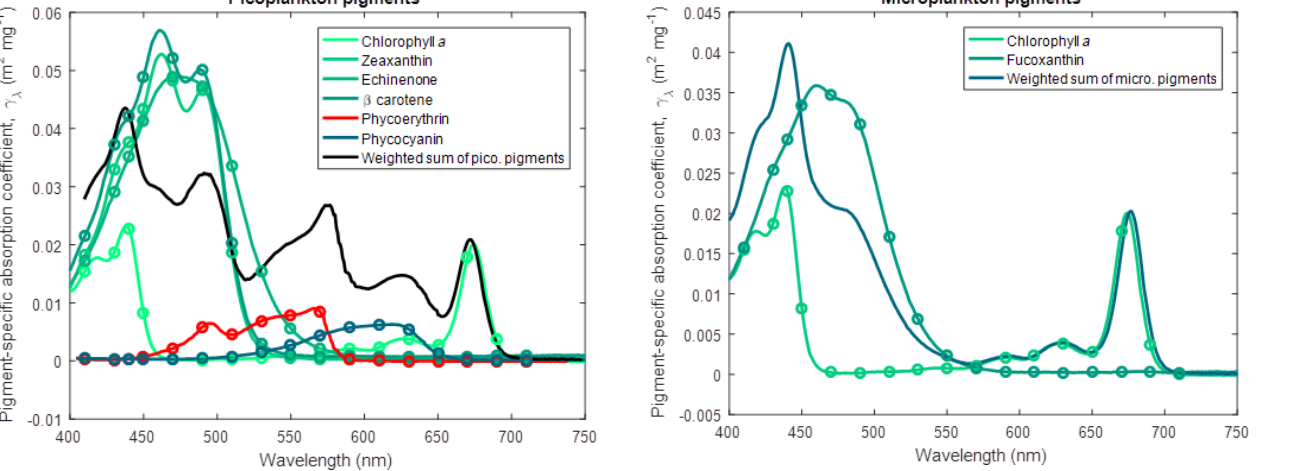
Figure 5. Pigment-specific absorption coefficients for the dominant pigments found in small phytoplankton determined using labora- tory standards in solvent in a 1cm vial. Green and red lines are pho- tosynthetic pigments constructed from 563 measured wavelengths. Circles represent the wavelengths at which the optical properties are calculated in the simulations. The black line represents the weighted sum of the photosynthetic pigments (Eq. 3), with the weighting calculated from the ratio of each pigment concentration to chloro- phyll a . The spectra are wavelength shifted from their raw measure- ment by the ratio of the refractive index of the solvent to the refrac- tive index of water (1.352 for acetone used with chlorophyll a and β carotene; 1.361 for ethanol used with zeaxanthin and echinenone; 1.330 for water used with phycoerythrin and phycocyanin).